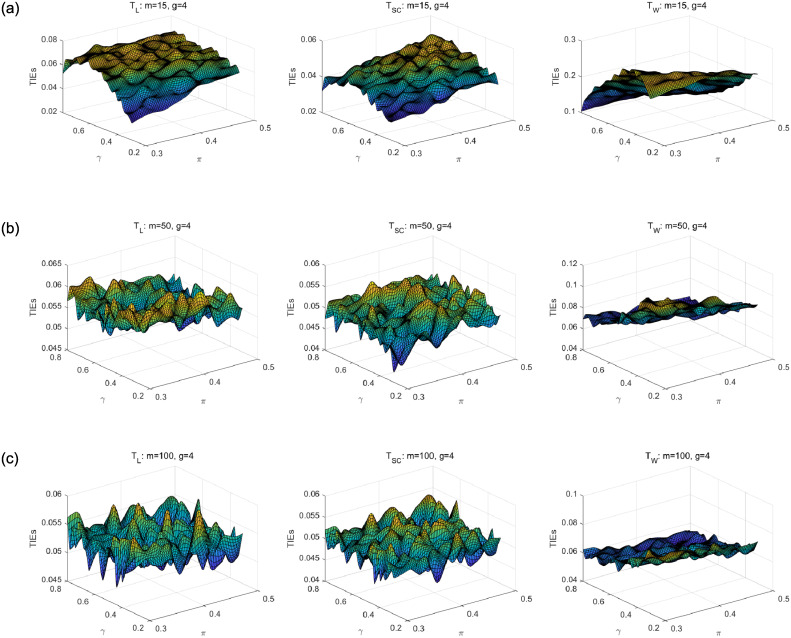
Empirical TIE surfaces of asymptotic tests for g = 4, πi = π and γi = γ.